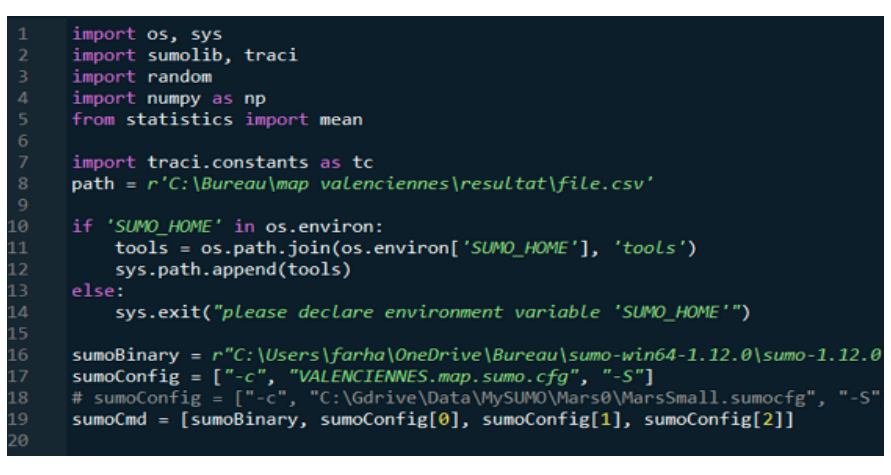
Figure 7. Importing TraCi in a script.